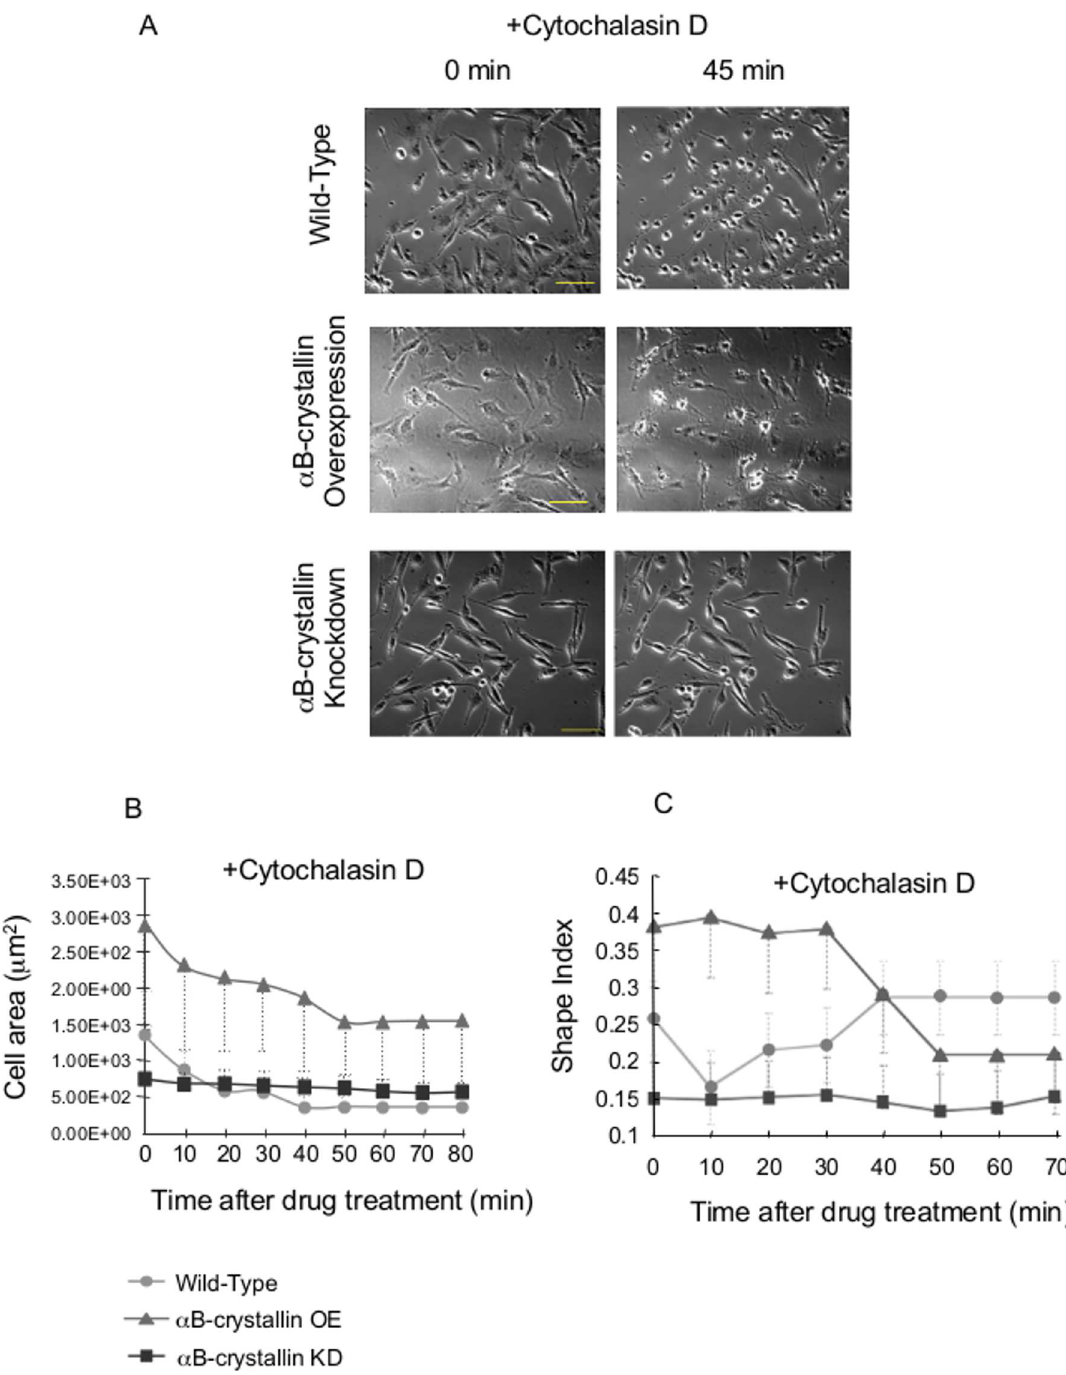
Fig 6. Effect of cytochalasin D on C6 α B-crystallin-overexpressing and knockdown cells. Just after drug addition (final 0.4 μ M; 0 min, left panel)and 45 min (right panel)(A). Cell area (B) and Shape index (C) changeof C6 cells after Cytochalasin D (final 0.4 μ M). N =